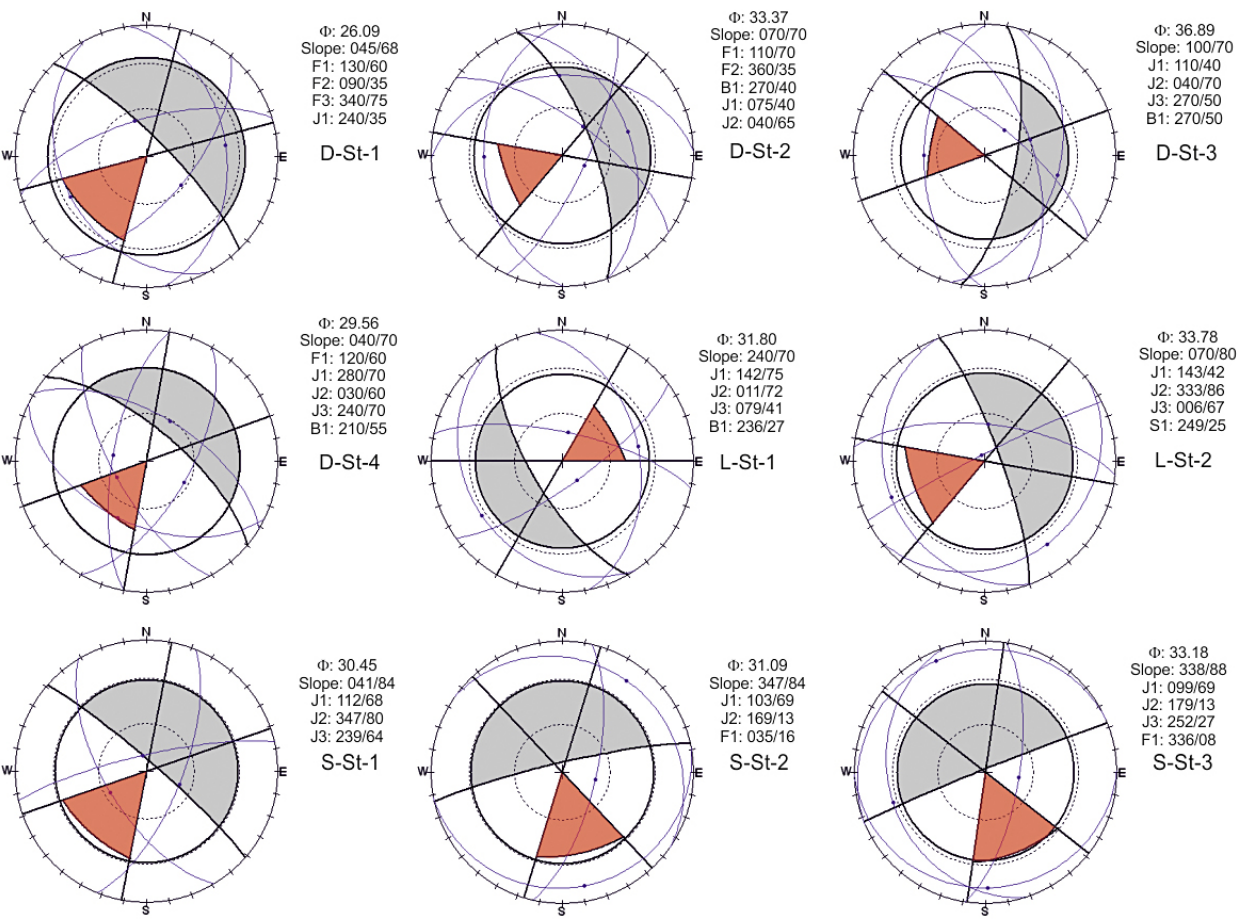
Figure 4. Markland test stereographic projections. Grey areas represent wedge and planar failure critical areas; red areas represent toppling failure critical